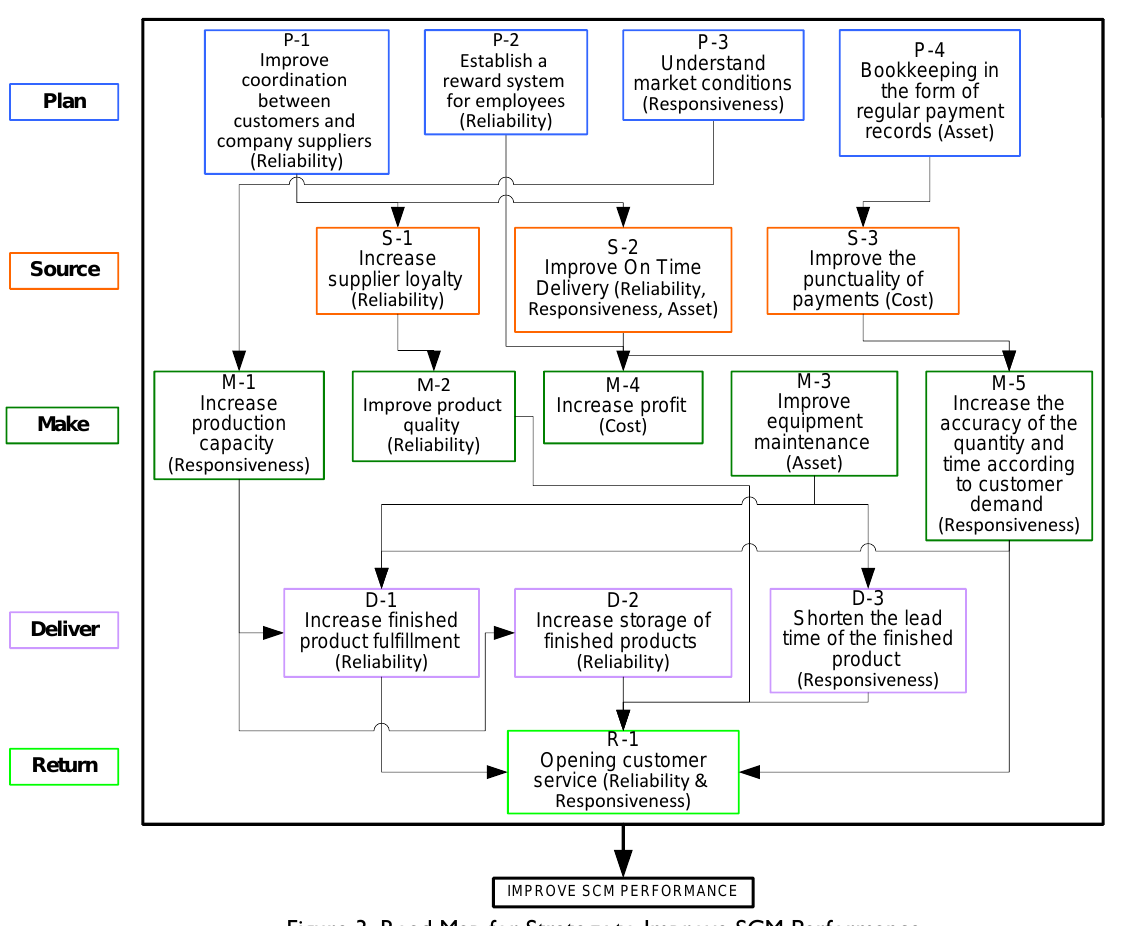
Figure 3. Road Map for Strategy to Improve SCM